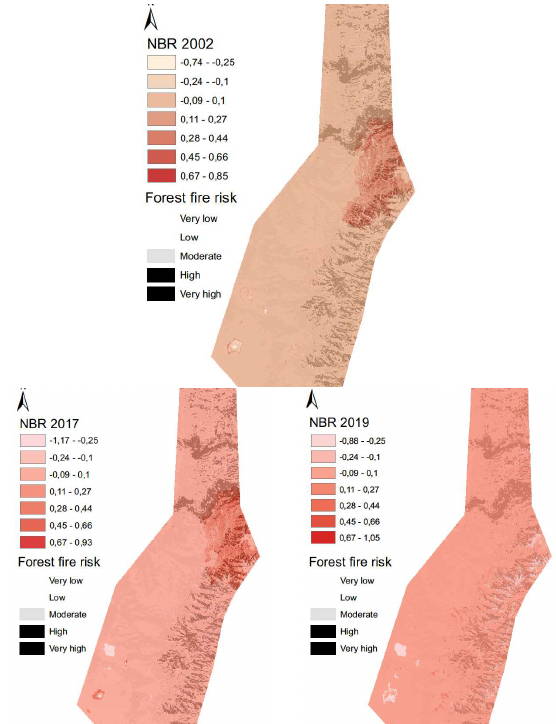
Figure 8 (continuation). NBR index and forest fire risk maps